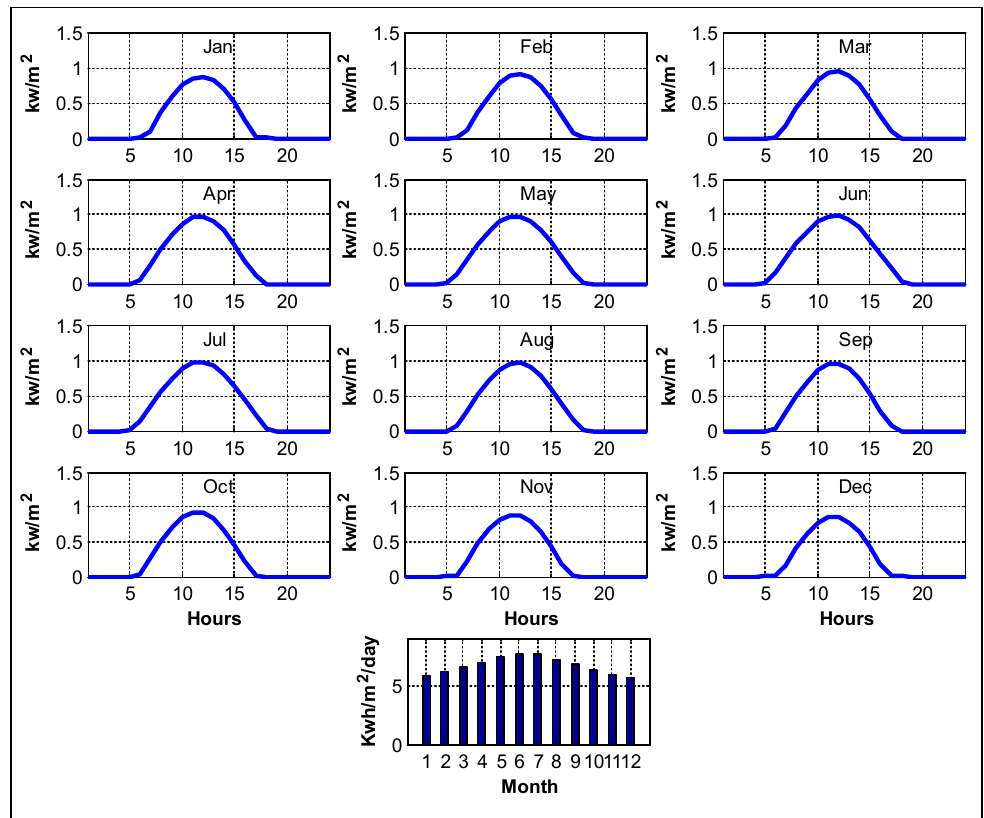
Figure 17. Daily hourly solar radiation for each month with optimum tilt angle using MATLAB program in New Delhi